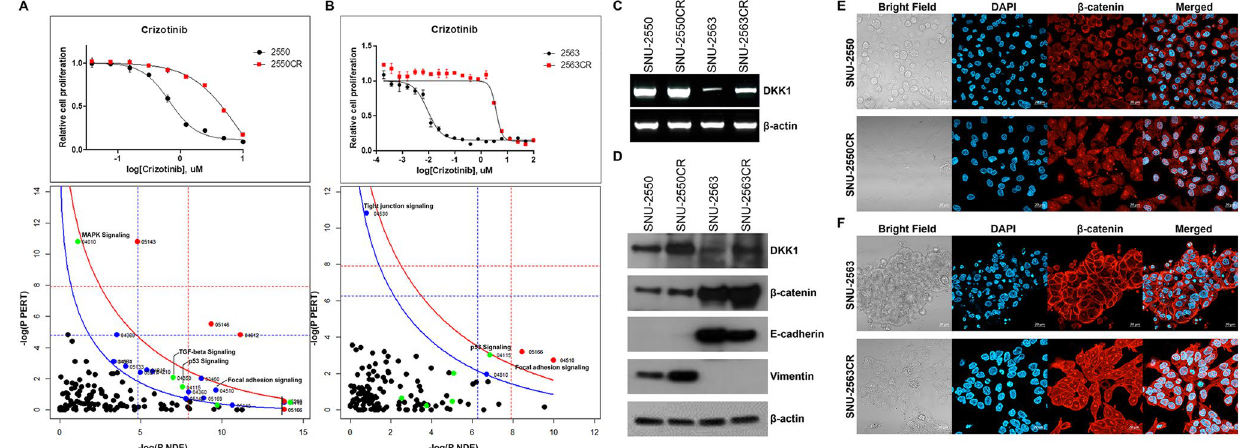
Figure 4. Repetitive exposure to crizotinib causes nuclear localization of β-catenin in MPE-derived NSCLC through increased DKK1 expression. ( A , B ) Two cell lines with EML4-ALK fusion were repetitively exposed to crizotinib in order to induce crizotinib resistance (CR). Both cell lines exhibited poor responses compared to their parental cell lines. Within the SPIA evidence plot, a single point represents each pathway and the coordinates are the log of over-representation p -value (pNDE) and the p -value from perturbations (pPERT). The oblique lines in the plot show the significance regions based on the combined evidence. The pathways at the right of the red curve are significant after Bonferroni correction of the global p -values, obtained by combining the pPERT and pNDE using the normal inversion method. The pathways at the right of the blue curve line are significant after a FDR correction of the global p -values. ( C) The mRNA level of DKK1 was increased on both CR sublines. ( D) The protein level of DKK1 was augmented as well on both CR sublines. The increased DKK1 barely affected the expression of β-catenin and E-cadherin. ( E,F) Distinct nuclear localization of β-catenin was observed by both CR sublines. Scale bar = 20